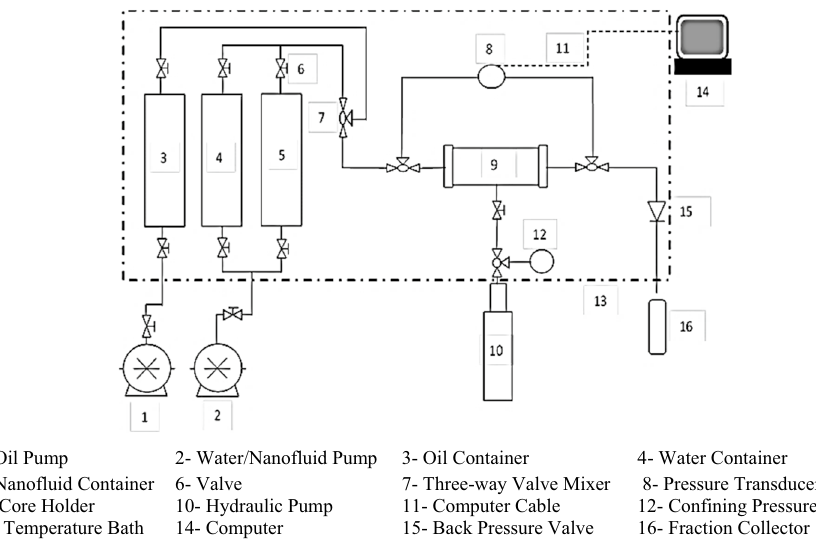
Fig. 2 Schematic diagram of core flooding